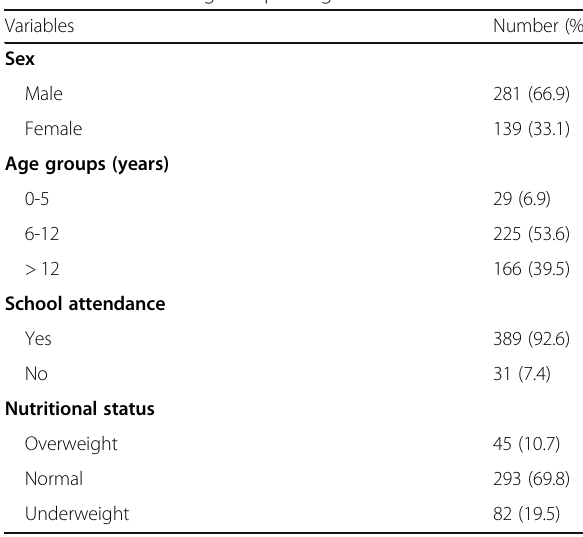
Table 1 Socio-demographic characteristics and